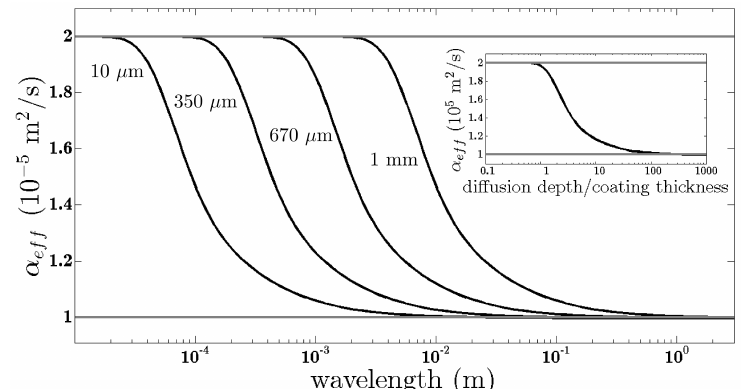
Figure 17. Example of a thermal dispersion curve, i.e., of the effective diffusivity as a function of the wavelength, for an aluminum-aluminum coating-substrate structure with a coating thickness ranging from 10 µ m to 1 mm. The lines of constant thermal diffusivity of the coating ( α 1 = 2 × 10 − 5 m 2 /s) and the substrate ( α 2 = 1 × 10 − 5 m 2 /s) were added to guide the eye. The inset shows the effective diffusivity as a function of the dimensionless diffusion depth over wavelength ratio were all the curves are